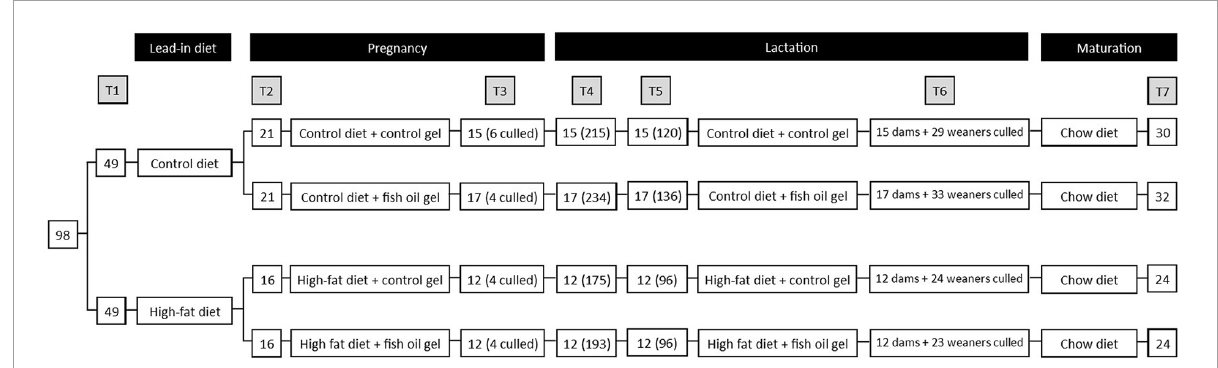
FIGURE1 Study design. T1: Initial randomization to diet, T2: Mating and randomization to gel treatment, T3: subset of dams culled on day 20 of pregnancy, continued dam number (culled dam number), T4: Pups delivered, dam number (pup number), T5: Litters standardized on postnatal day 2, dam number (pup number), T6: dams and weaners culled on postnatal day 21. 1 male and 1 female weaner per litter utilized for adult assessments. T7: adult male and female offspring culled at day 100, number represents total of male and female pups. Note that 1 pair of cohoused female offspring in the Con-FO group were excluded due to misattribution of sex that led to